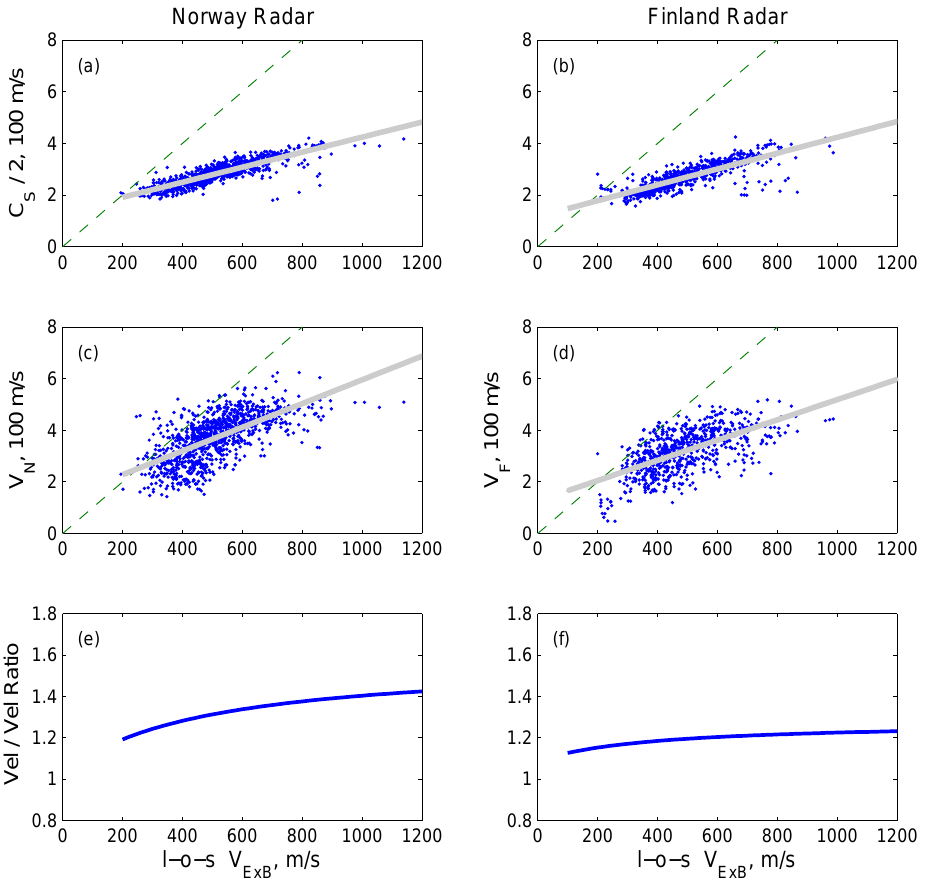
Fig. A1. (a) and (b) are the terms C s cos 2 N , F , 2 N , F = 60 ◦ , in accordance with suggestion by Bahcivan et al. (2005), blue points; (c) and (d) are STARE velocities velocity-to-velocity ratio V N , F see text in Sect.